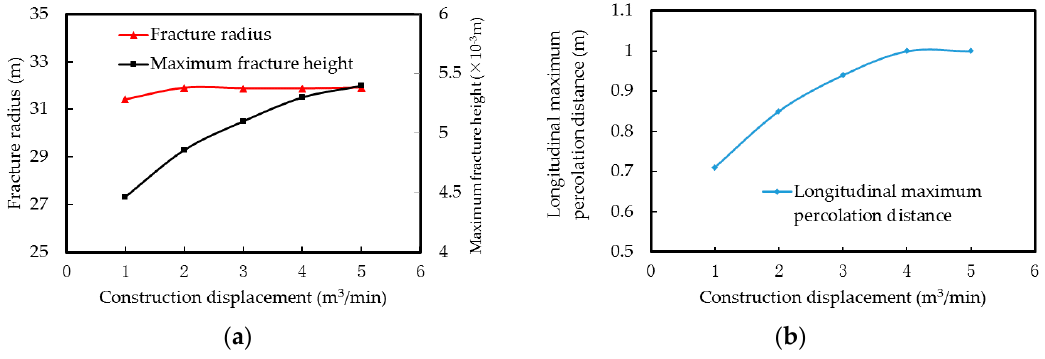
Figure 11. Influence of construction displacement on fracture morphology and longitudinal maximum percolation distance: ( a ) Influence of displacement on morphology and ( b ) influence of displacement on longitudinal maximum percolation distance.